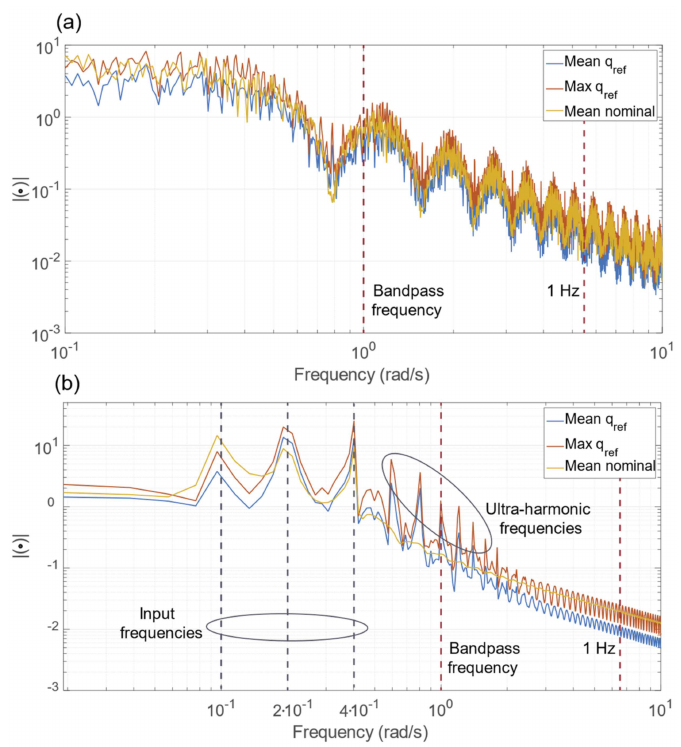
Figure 9. ( a ) Frequency analysis for the step path. The spectra of the mean and the maximum q ref signal are presented, compared with the spectrum of the nominal dynamics highlighting the band-pass frequency of F(s). ( b ) Frequency analysis for the sinusoidal path. The spectra of the mean and the maximum q ref signal are depicted, compared with the spectrum of the nominal dynamics highlighting some notable